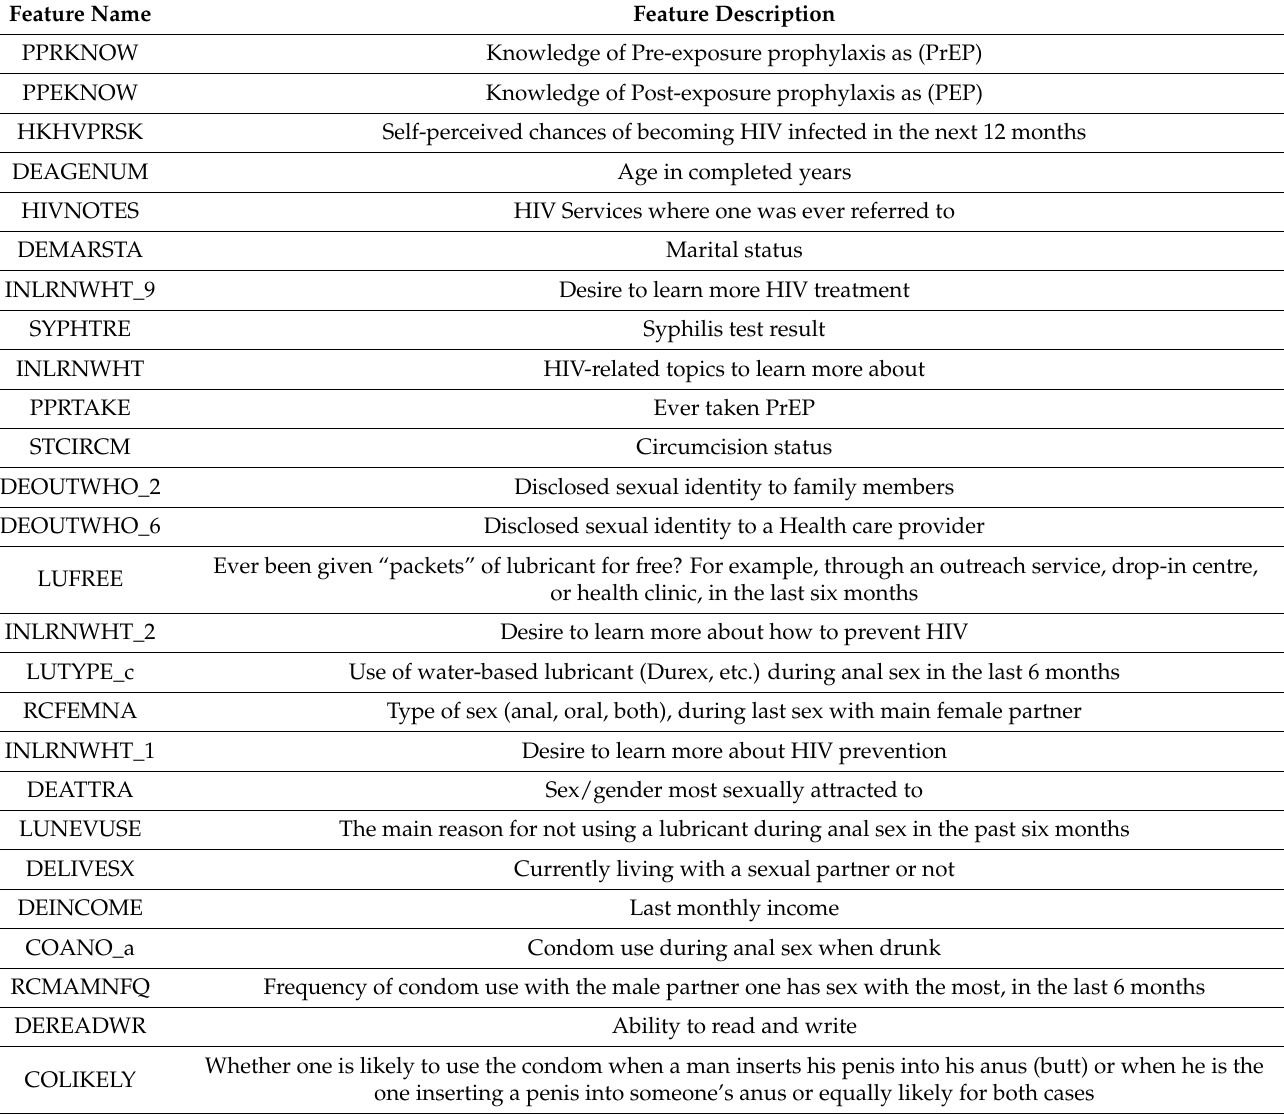
Table 1. Description of